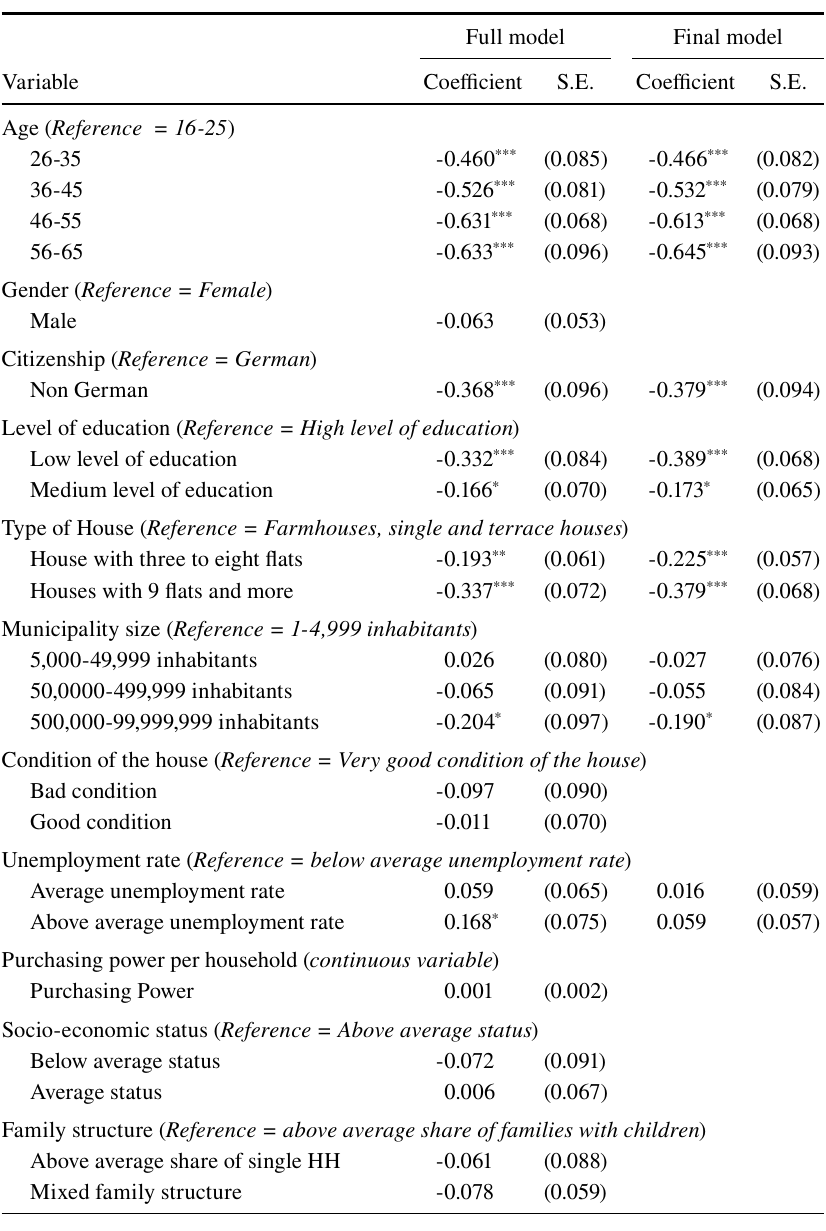
Logistic regression models predicting